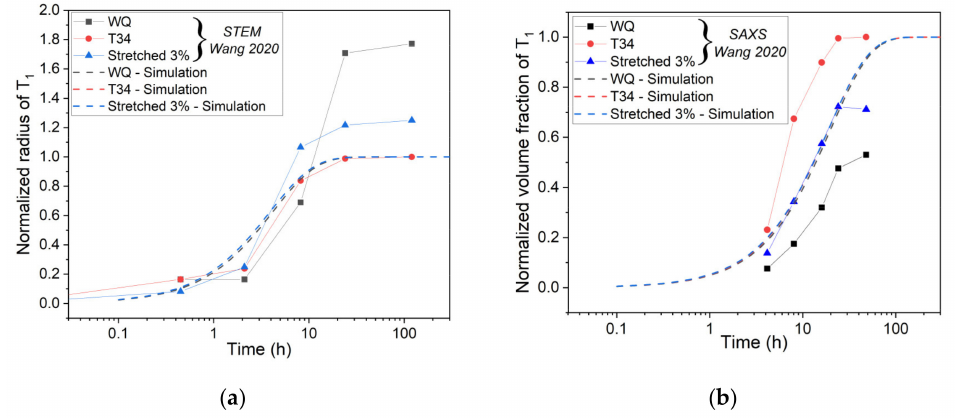
Figure 8. The evolution of simulated and experimental ( a ) normalized radius and ( b ) volume fraction of the T 1 precipitates in WQ, T34, and Stretched 3% samples during heat treatment at 155 ◦ C. The original model of Li et al. [9] is used for the simulations. Experimental data comes from Wang et al.